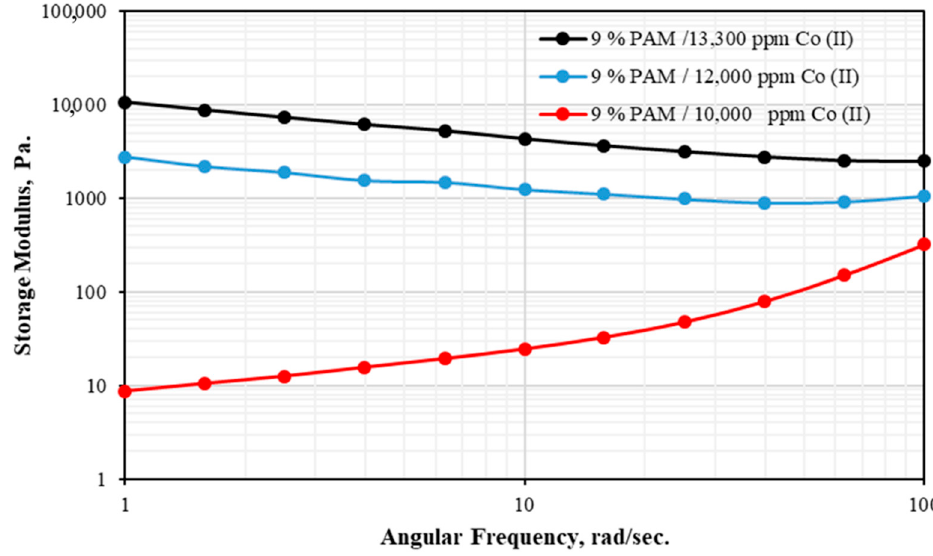
Figure 4. E ff ect of Co (II) concentration on mature gel storage modulus (25 ◦ C, pH = Figure 4. Effect of Co (II) concentration on mature gel storage modulus (25 °C, pH = 7.25).